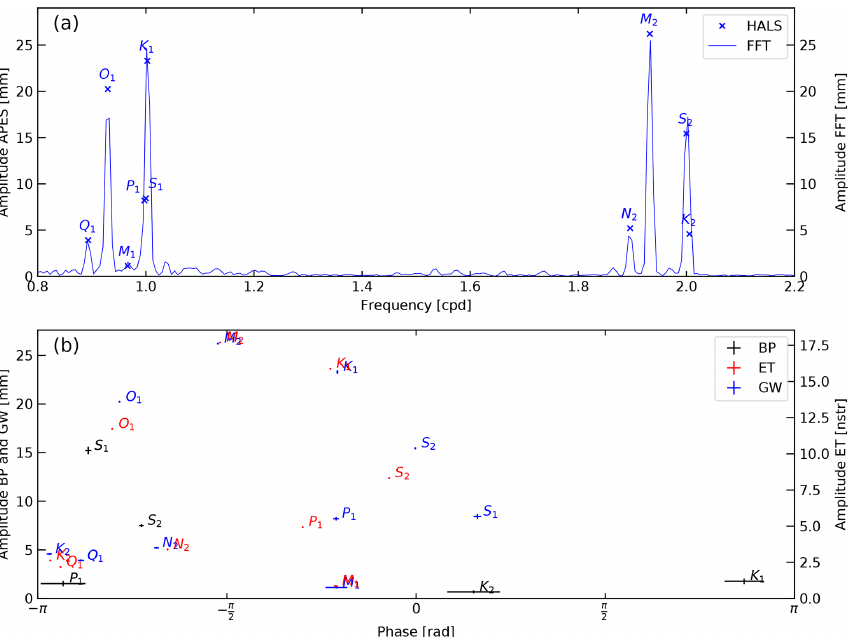
Figure 3. (a) A comparison of groundwater (GW) amplitudes for the interval 0 . 8 ≤ f ≤ 2 . 2 cycle per day (cpd) derived using the general harmonic least squares estimation (Eq. 12) and the standard fast Fourier transform. (b) Amplitudes and phases of the most common tidal components in groundwater (GW), barometric pressure (BP) and Earth tides (ET) determined using harmonic least squares estimation. Note that horizontal and vertical error bars show the uncertainty of 1 standard deviation (Appendix